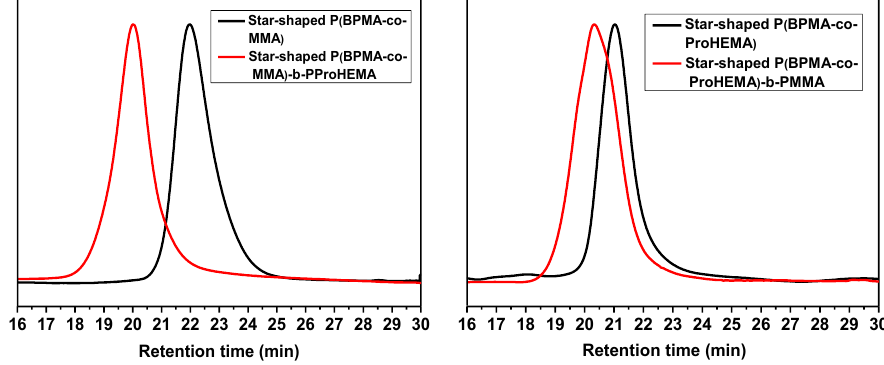
Figure 1. Synthesis of star-shaped block copolymers monitored by GPC traces (RI signal) (reaction conditions, molar ratio).